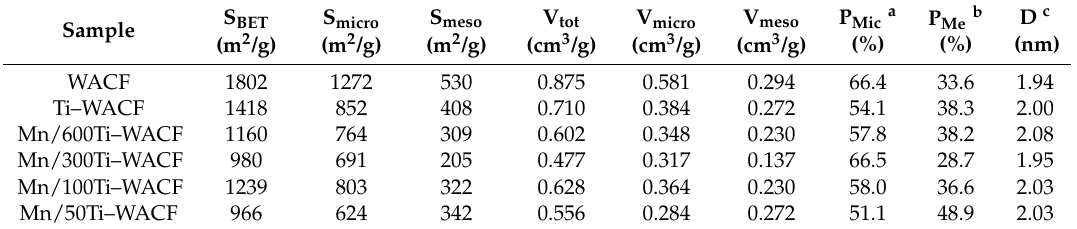
Table 2. Specific surface area, pore volume, and aperture parameters of WACF and Mn/TiO2–WACF.